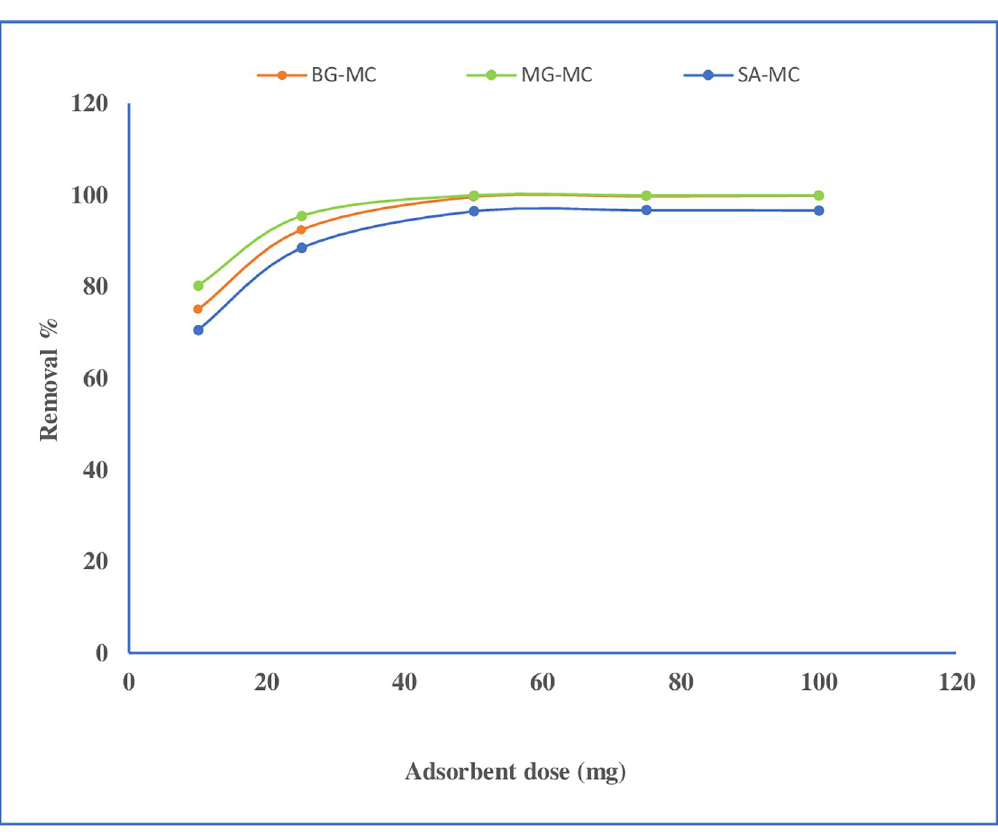
Fig 8. Effect of adsorbent dose on dye